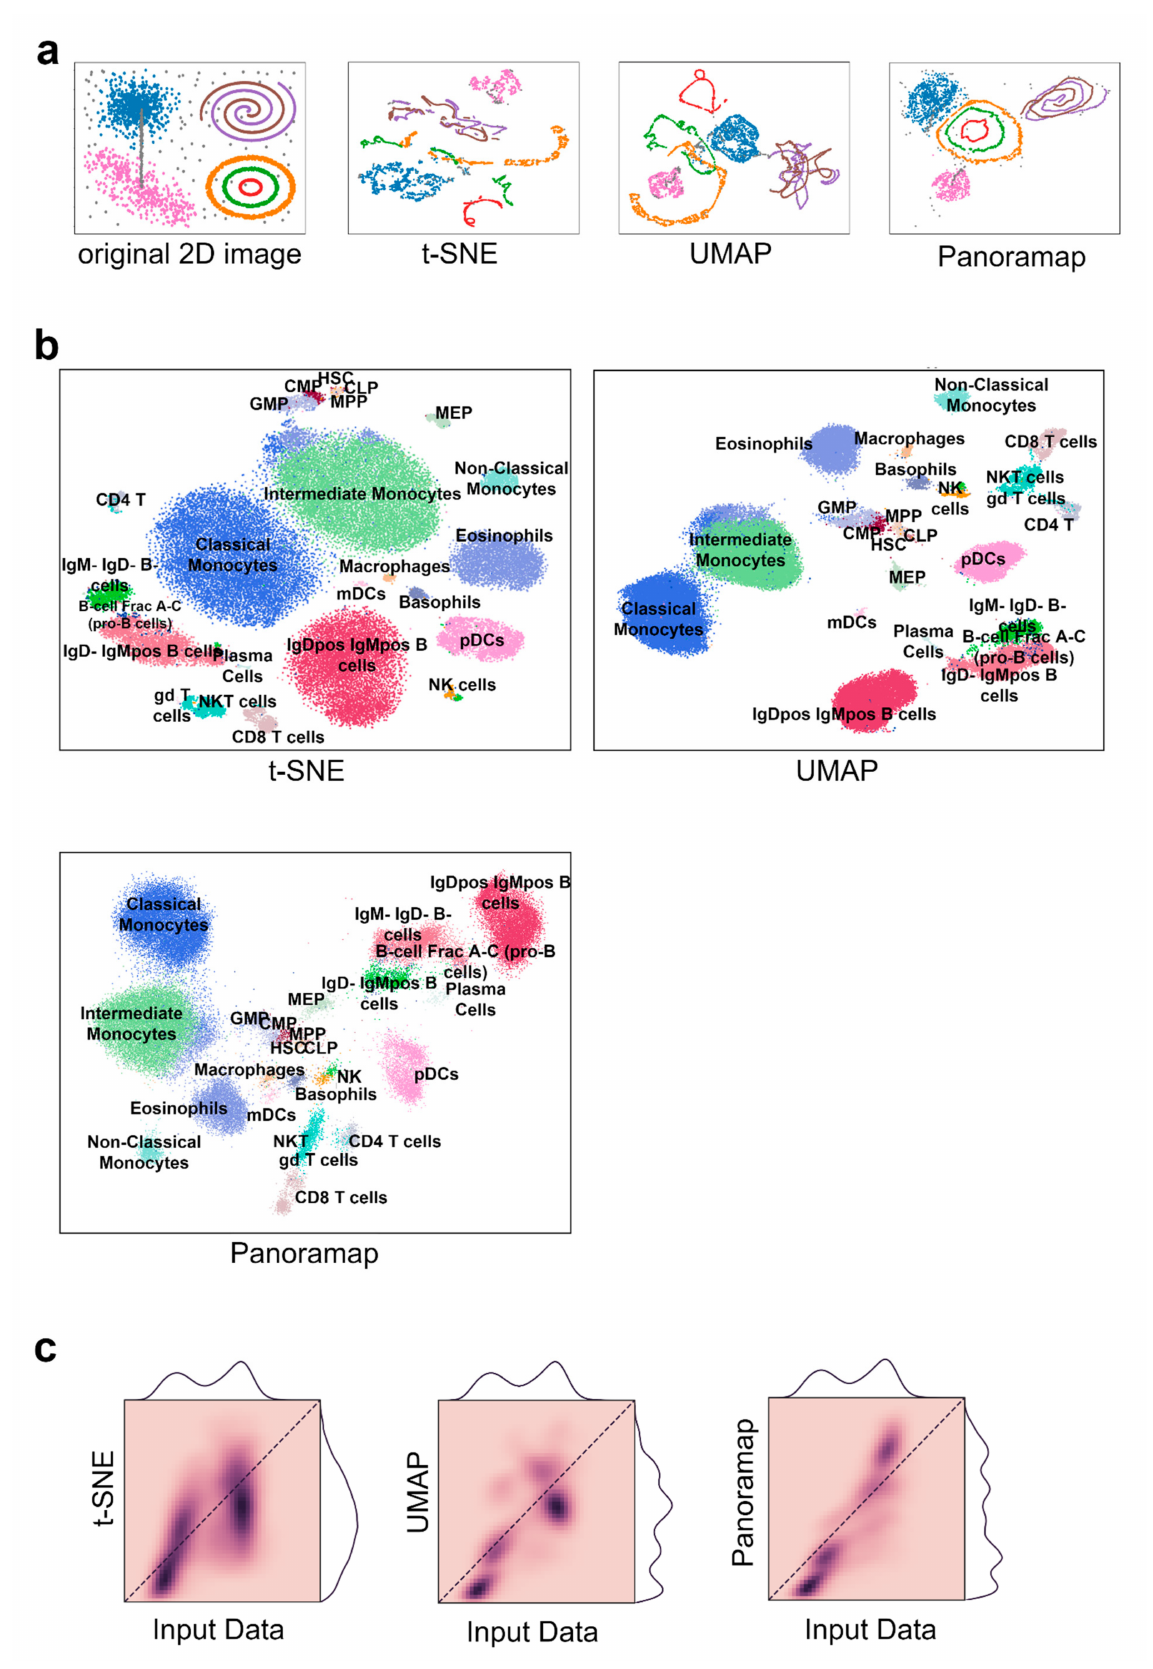
Figure 2. Panoramap best preserves topological and geometrical structures of input data. ( a ) A mixture of 7 distinct manifolds and ambient noise (grey color) in 2-dimensional (2D) are